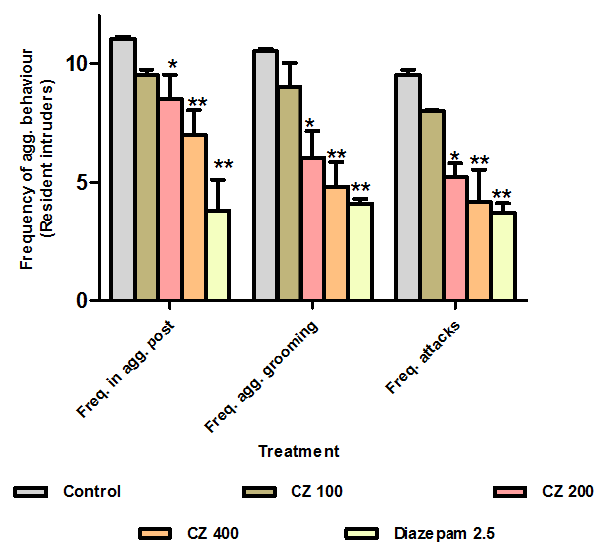
Fig. 6. Effect of EECZ on latency period of first attack against res- ident intruder. Control = 6 and treatment extract n=6,* p <0.05, ** p <0.001 compared to control